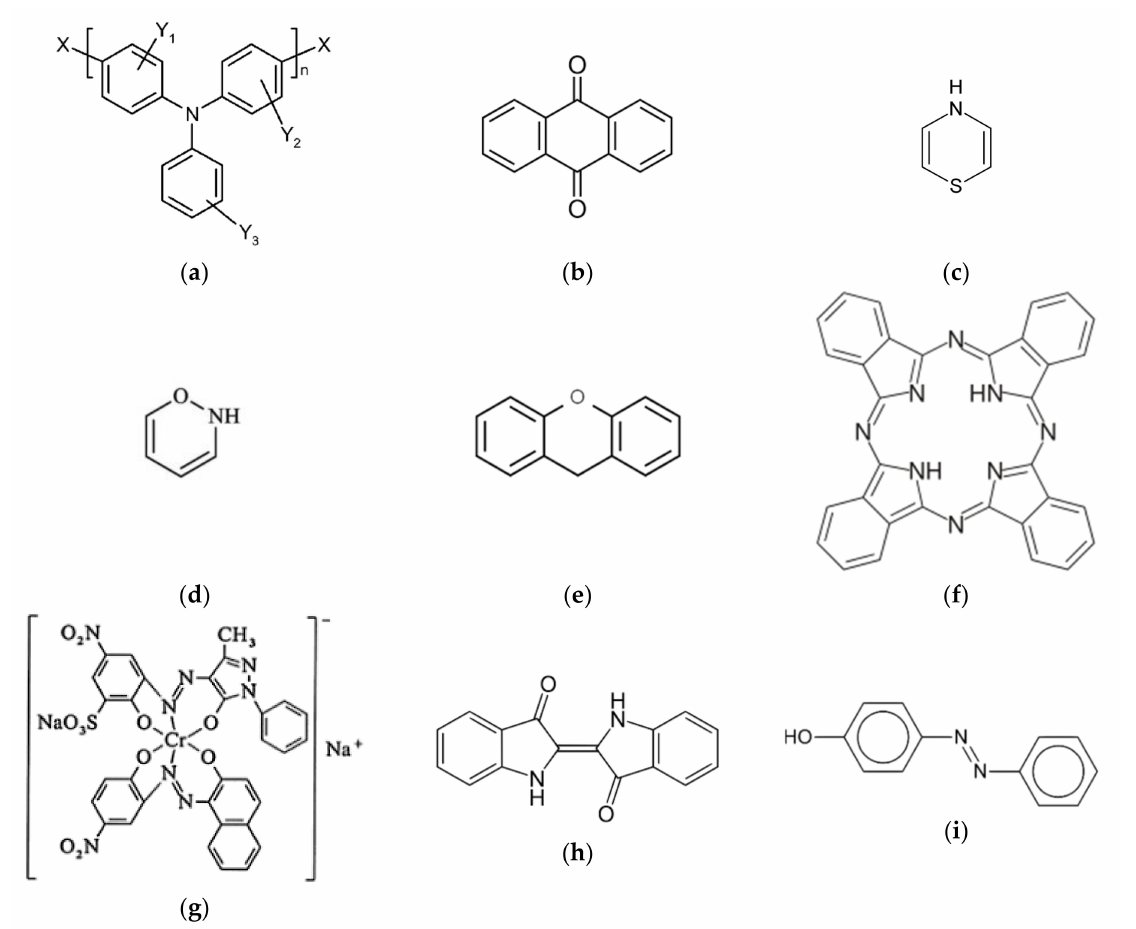
Figure 1. Chemical structure of the dyes investigated with their distinguished chromophore groups: ( a ) triarylamine, ( b ) anthraquinone, ( c ) thiazine, ( d ) oxazine, ( e ) xanthene, ( f ) phthalocyanine, ( g ) metal complex, ( h ) indigo and ( i ) azo